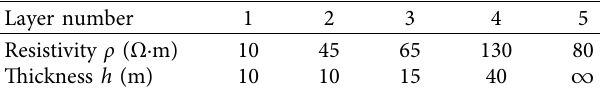
Figure 4: Descent curves of iterative computation obtained by different inversion algorithms.